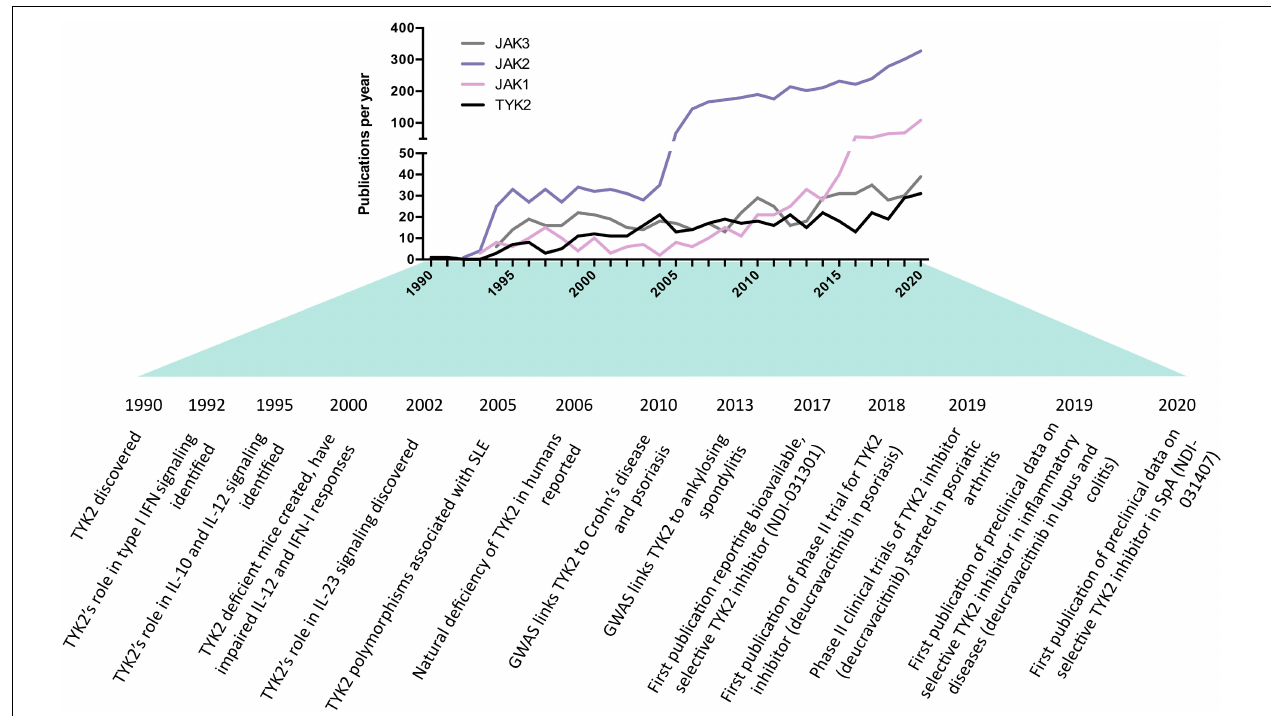
FIGURE 1 | History and milestones of Janus kinase (JAK) research, with an emphasis on tyrosine kinase 2 (TYK2) in the context of SpA. Data obtained from SCOPUS database using searching the abstract and title for short name (e.g., “TYK2”) or long name (e.g., “tyrosine kinase 2”). The increase in JAK2 publications was likely driven by the discovery of JAK2 mutations in myeloproliferative disorders in 2005. The increase in JAK1 publications coincided with the discovery of its role in leukemia.